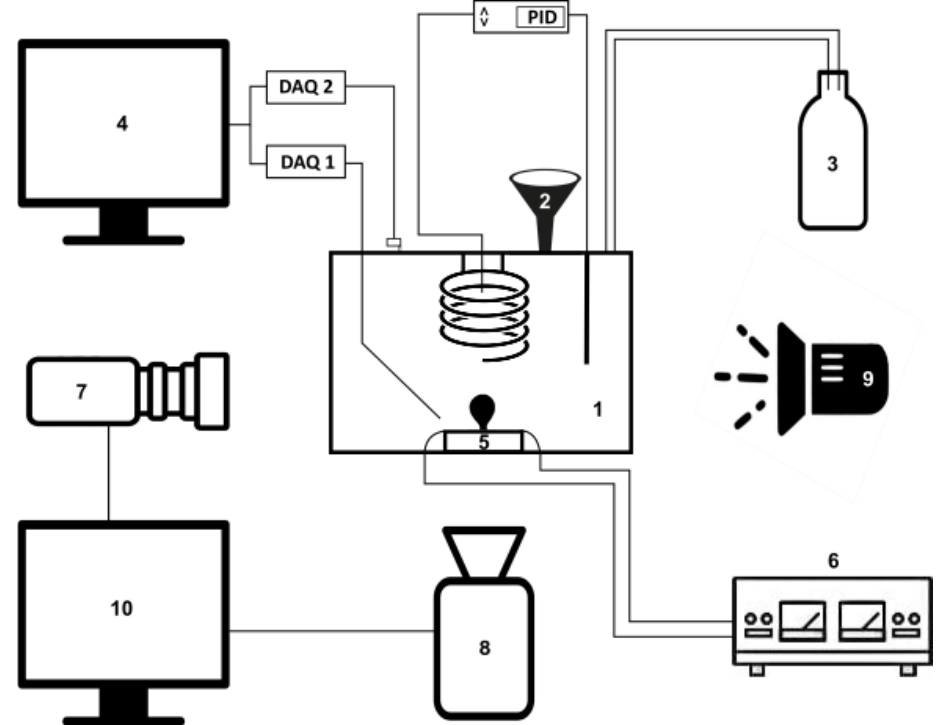
Figure 1. Schematic view of the experimental setup: (1) boiling chamber, (2) funnel, (3) condensed fluid recipient, (4) computer, (5) tank base, (6) DC power supply, (7) high-speed camera, (8) infrared camera, (9) LED, and (10) Personal computer.